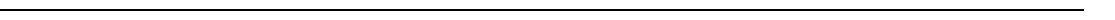
Fig. 6 Ca 2 + -activated TFEB reprograms macrophage metabolic mode. a Extracellular acidi fi cation rate (ECAR) of BMDM-M2 cells was measured with or without 10 μ M CQ treatment ( n = 3). b Oxygen consumption rate (OCR) of BMDM-M2 cells were measured with or without 10 μ M CQ treatment ( n = 3). c ECAR (left) and OCR (right) in Mcoln1-SGGFP and Mcoln1-SGRNA Raw264.7 cells were measured with or without CQ treatment ( n = 3). d ECAR (left) and OCR (right) were measured in Raw264.7 cells pretreated for 2 h with 1 μ M CsA or not before addition of CQ or PBS ( n = 3). e ECAR (left) and OCR (right) in Tfeb and control (NC) siRNA Raw264.7 cells were measured with or without CQ treatment ( n = 3). f The mRNA expression of Scl2a1 , Slc2a4 , Pfkm , and Pklr were analyzed by real-time qPCR in Tfeb and control (NC) siRNA Raw264.7 cells with or without CQ treatment ( n = 3). g The mRNA expression of Nos2 and Arg1 were analyzed by real-time qPCR in Tfeb and control (NC) siRNA Raw264.7 cells that had been treated with PBS or CQ ( n = 3). h ECAR (left) and OCR (left) were measured in BMDM-M2 cells that had been pretreated for 2 h with 10 μ M SB203580 or not before addition of CQ or PBS ( n = 3). i ECAR (left) and OCR (left) were measured in BMDM-M2 cells that had been pretreated for 2 h with 10 μ M JSH-23 or not before addition of CQ or PBS ( n = 3). Data shown are representative of three independent experiments and error bars represent mean ± SEM. * P < 0.05; ** P < 0.01; *** P < 0.001 (Student ’ s t